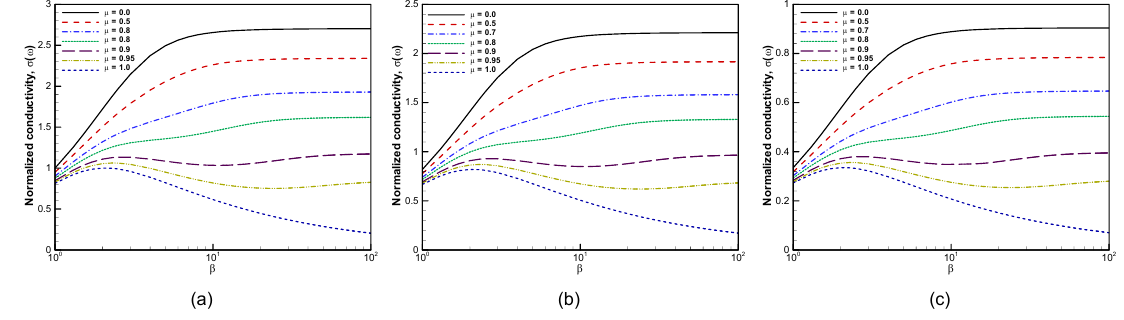
Figure 8. Computed electrical conductivity vs. inverse temperature for various chemical potential values µ = 0.0,0.5,0.7,0.8,0.9,0.95,1.0 at ( a ) E 0 = 10 3 V/cm, ( b ) E 0 = 10 4 V/cm, and ( c ) E 0 = 2.5 × 10 4 V/cm with ω = 1 and τ =